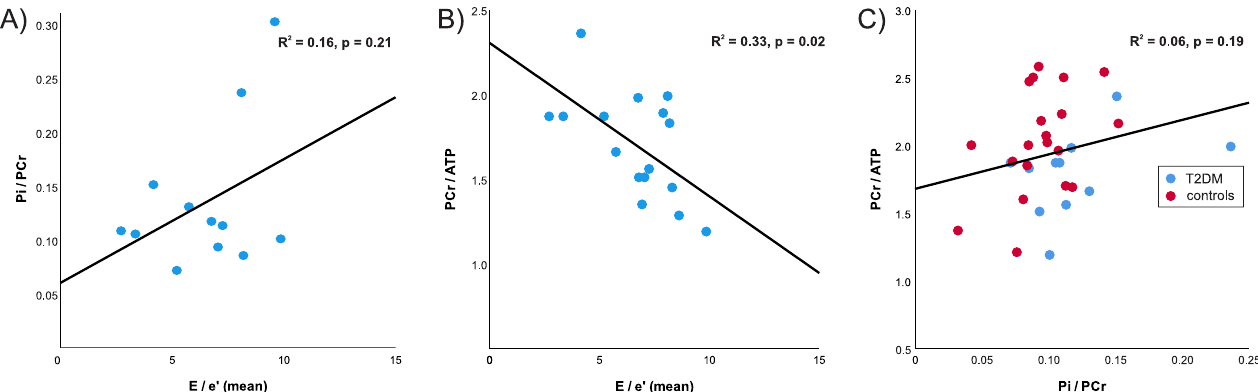
Fig 3. Correlation between cardiac metabolism and diastolic function in diabetic patients. E/e’ is an indicator of diastolic dysfunction with higher values indicating higher ventricular filling pressures. The parameter did not correlate with Pi/PCr (A) but did correlate inversely with PCr/ATP (B, p = 0.02) in the diabetics recruited. Overall, PCr/ATP did not correlate well with Pi/PCr but when plotted against one another (C) the shift to higher Pi/PCr and lower PCr/ ATP in T2DM can be appreciated.